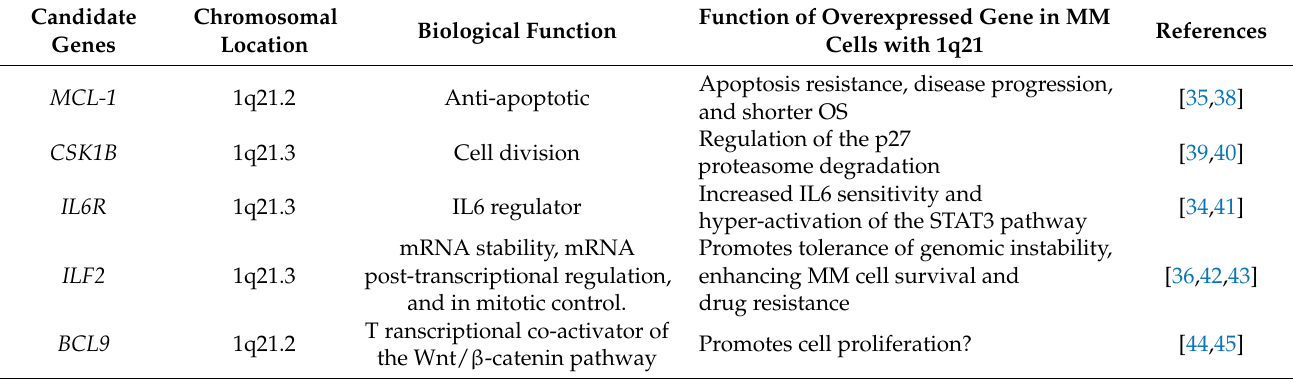
Table 1. Biological function and implications of candidate genes in MM cells with 1q21